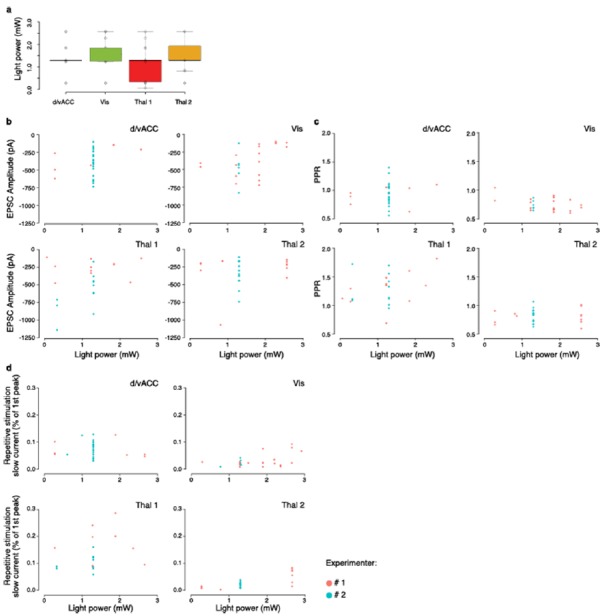
DOI:
http://dx.doi.org/10.7554/eLife.19103.029